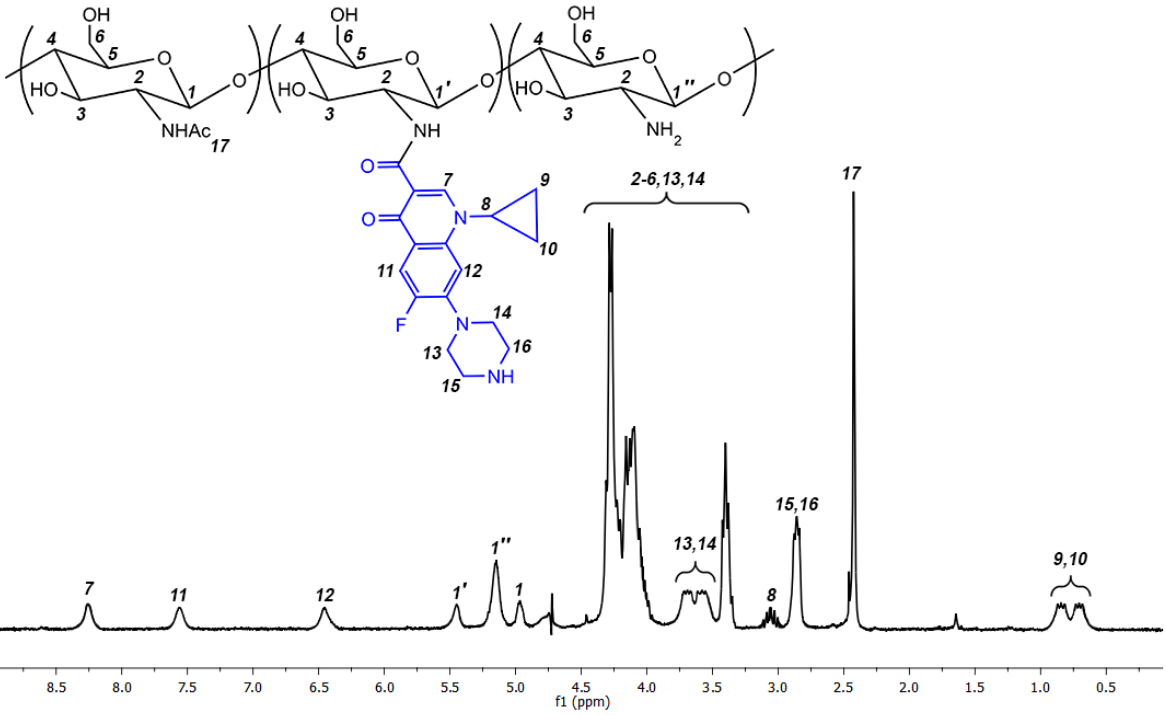
Figure 1. The typical 1 H NMR spectrum of ciprofloxacin/chitosan conjugate. Table 2. Degrees of substitution of the obtained of ciprofloxacin-conjugated chitosan derivatives without spacer (Scheme 1, system 1) and molecular weights of the starting chitosans.